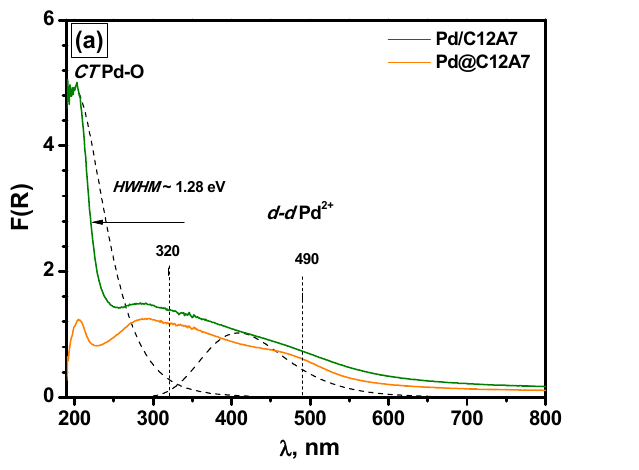
Figure 9. Diffuse reflectance UV–Vis spectra for Pd/C12A7 and Pd@C12A7: ( a ) as-prepared samples; ( b ) samples after catalytic tests in the PTA mode. Dashed lines show the characteristic charge transfer ( CT ) bands and d-d transition bands for Pd 2+ in square-planar coordination, which is typical for PdO clusters.